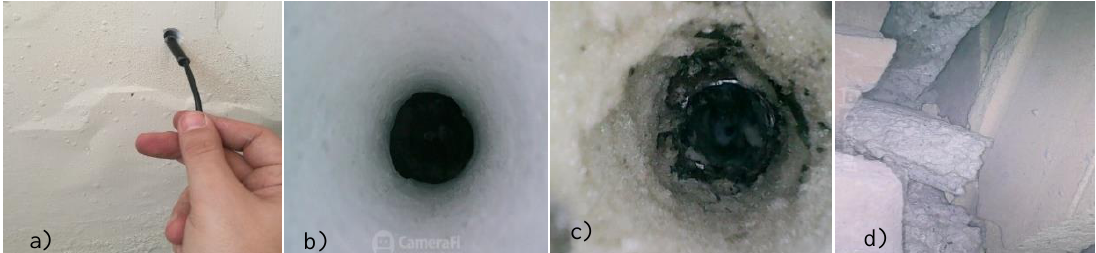
Figure 4. ( a ) Endoscope probe; ( b ) autoclaved concrete layer; ( c ) thermal insulation panel; ( d ) wall